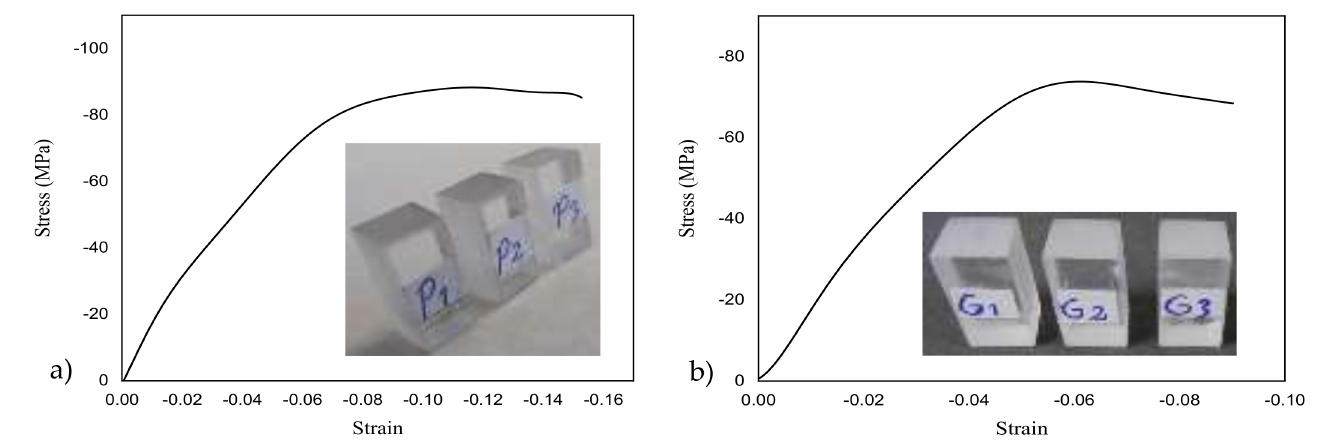
Figure 5. Compressive stress–strain curves for ( a ) PMMA and ( b ) general-purpose polystyrene